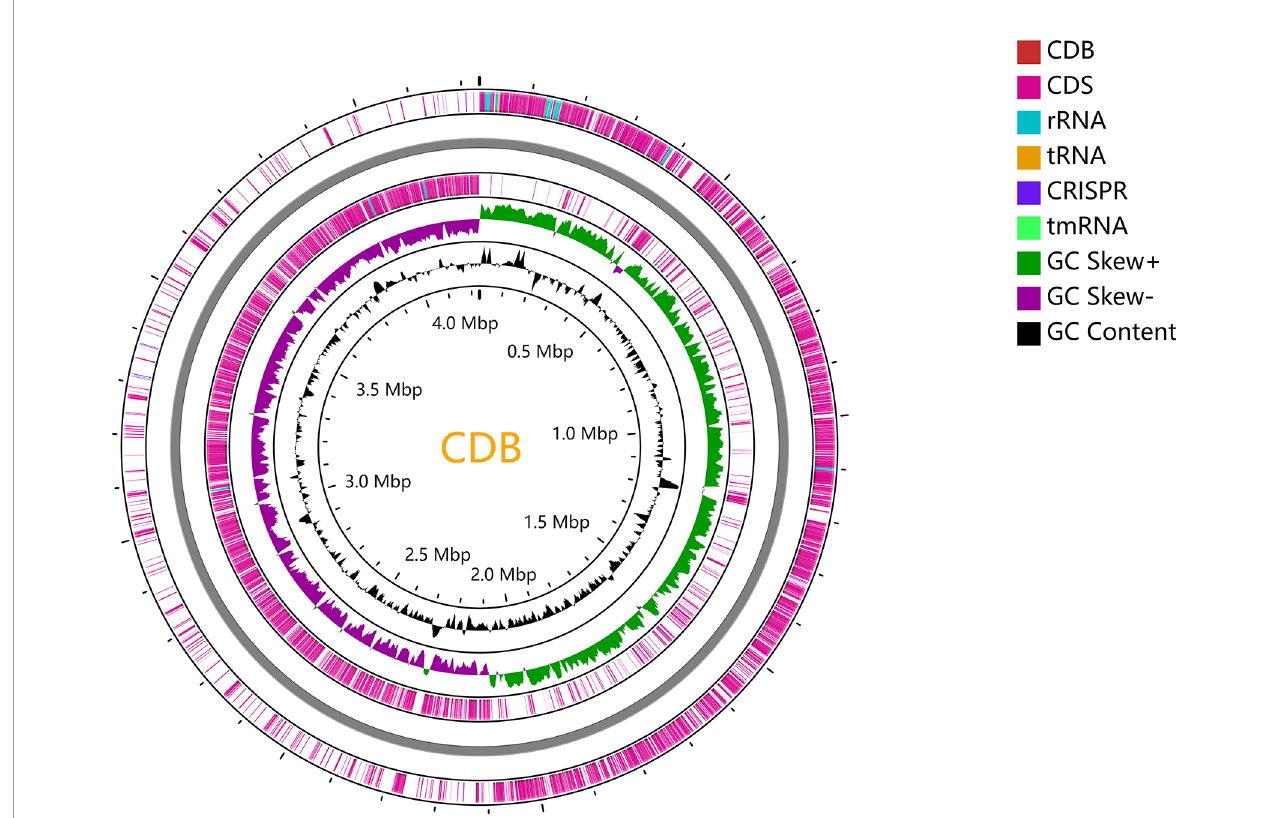
FIGURE 3 | Circular genome map of CDB. The circular genome has been generated with